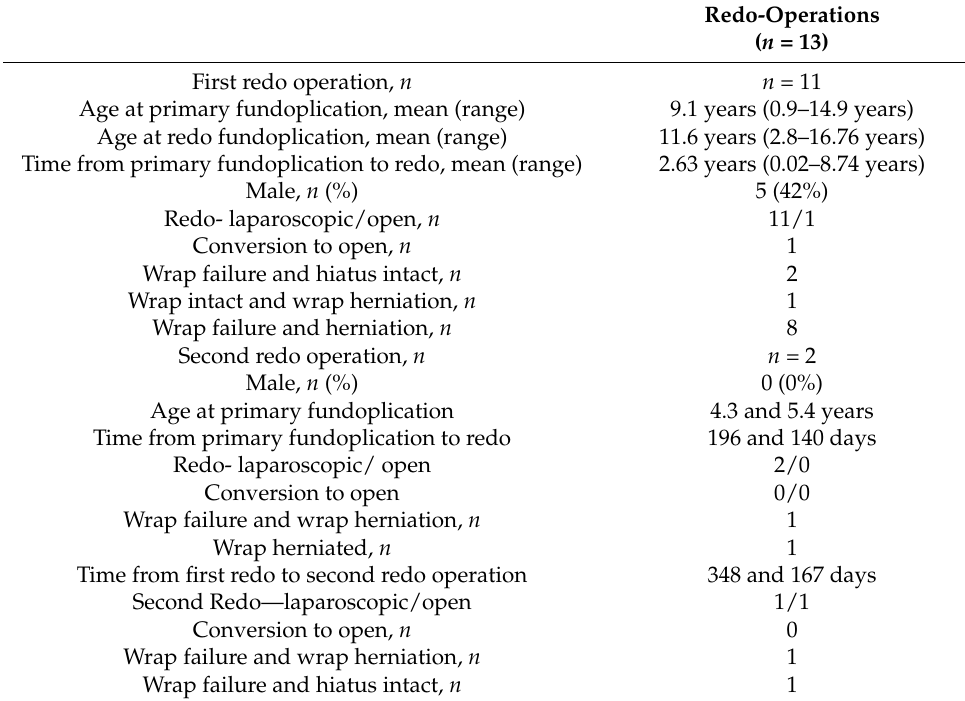
Table 3. Demographics of patients undergoing redo fundoplication.